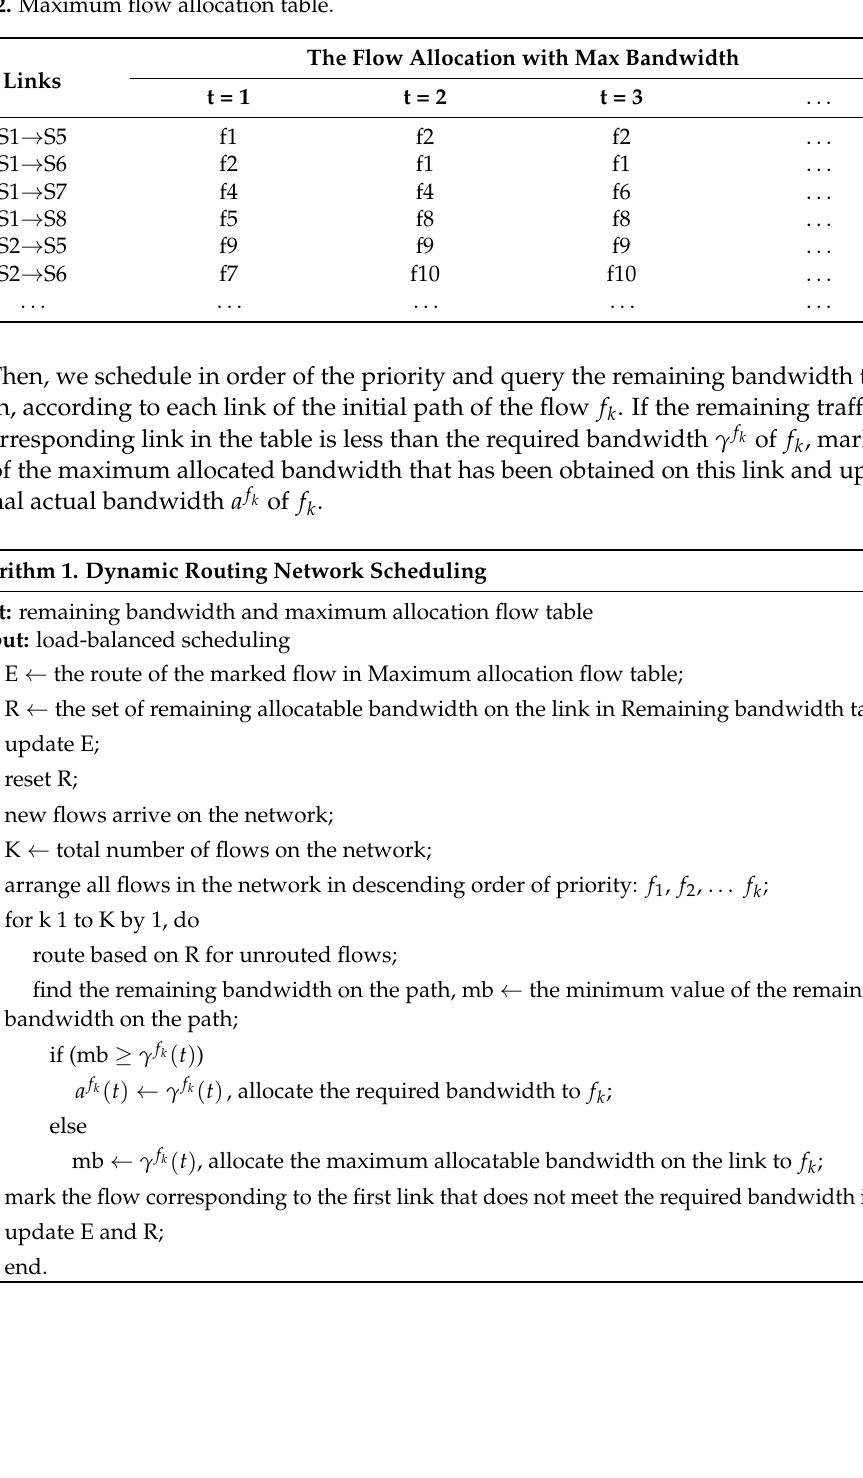
Table 2. Maximum flow allocation table.